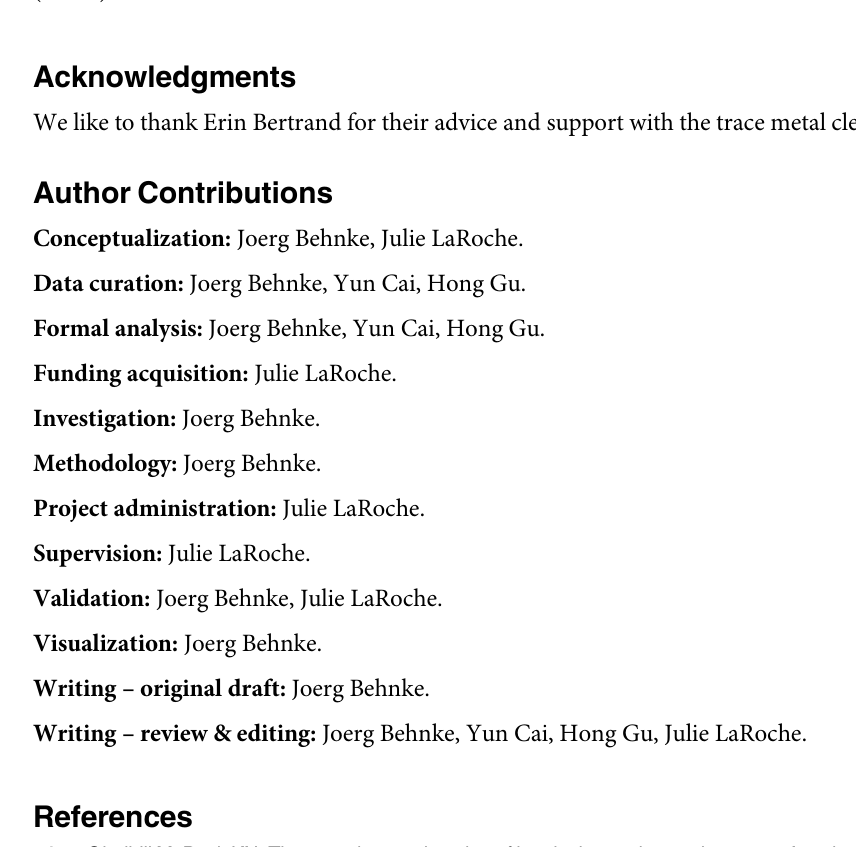
S5 Table. Overview of calculated changepoints and the p-value for targeted transcripts. The table shows the changepoints (CP) of targeted transcripts for three different treatments and the significance of the slope difference between and after the changepoint (p < 0.01). (XLSX) S1 File. Raw and normalized transcript counts. The four tables show the raw and normalized transcript counts from the targeted transcript analysis divided into the 44_probeset and the 24_probeset.